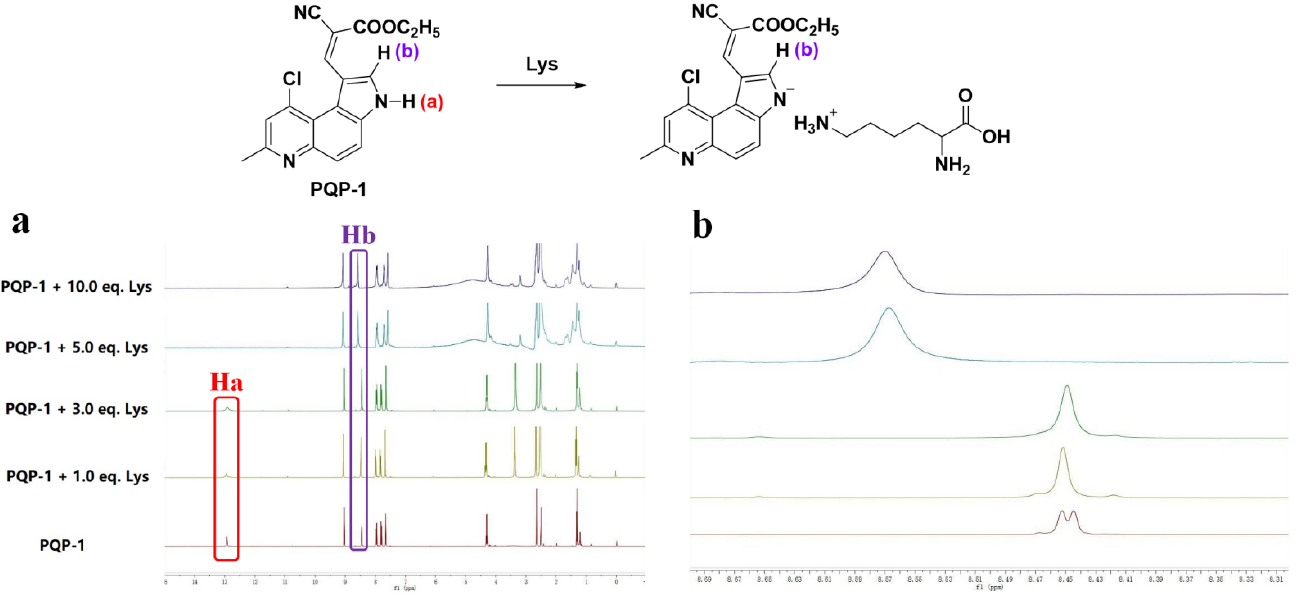
Figure 5. 1 H NMR titration experiments of PQP-1 in DMSO- d 6 (0.55 mL) on lysine. PQP-1 : 0.0051 g, 15 µ mol. ( a ) The comparison of 1 H NMR spectra of PQP-1 and the mixture after adding different concentrations of lysine. ( b ) The changes of peak type of Hb .